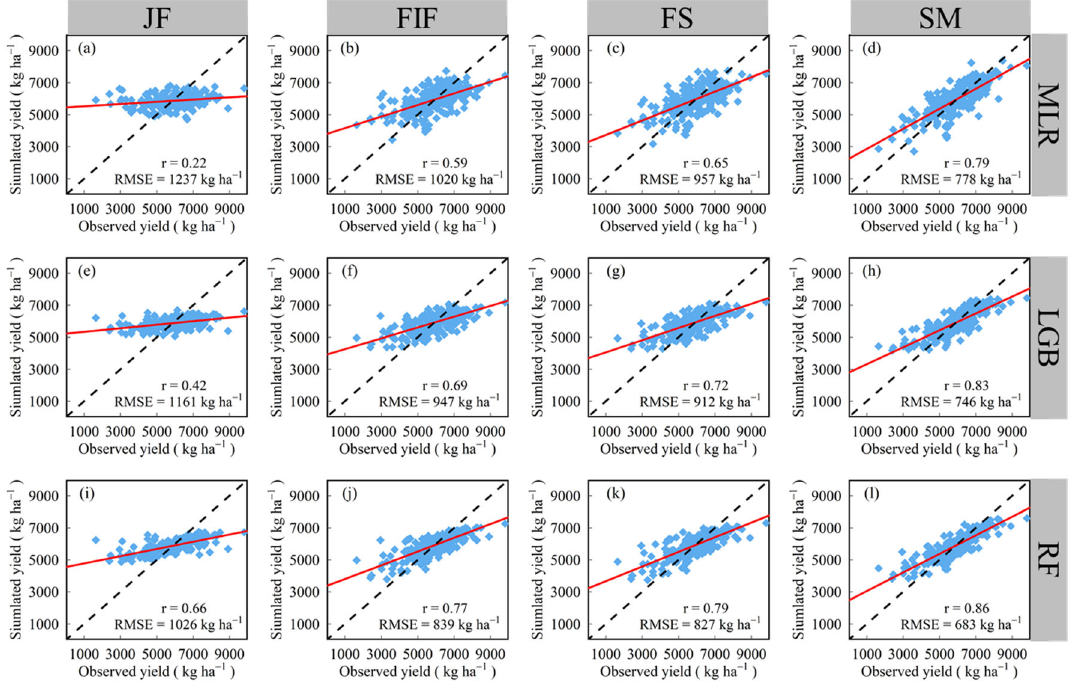
Figure 4. Comparison of the observed and predicted wheat yields for the period from the end of the juvenile stage to floral initiation (JF) ( a , e , i ), from floral initiation to flowering (FIF) ( b , f , j ), from the start of grain filling to the milky stage (FS) ( c , g , k ), and from flowering to the start of grain filling (SM) ( d , h , l ) from multiple linear regression (MLR) ( a – d ), light gradient boosting machine (LGB) ( e – h ), and random forest (RF) ( i – l ). Red lines are the linear regression fit. Dashed lines represent the 1:1 lines.